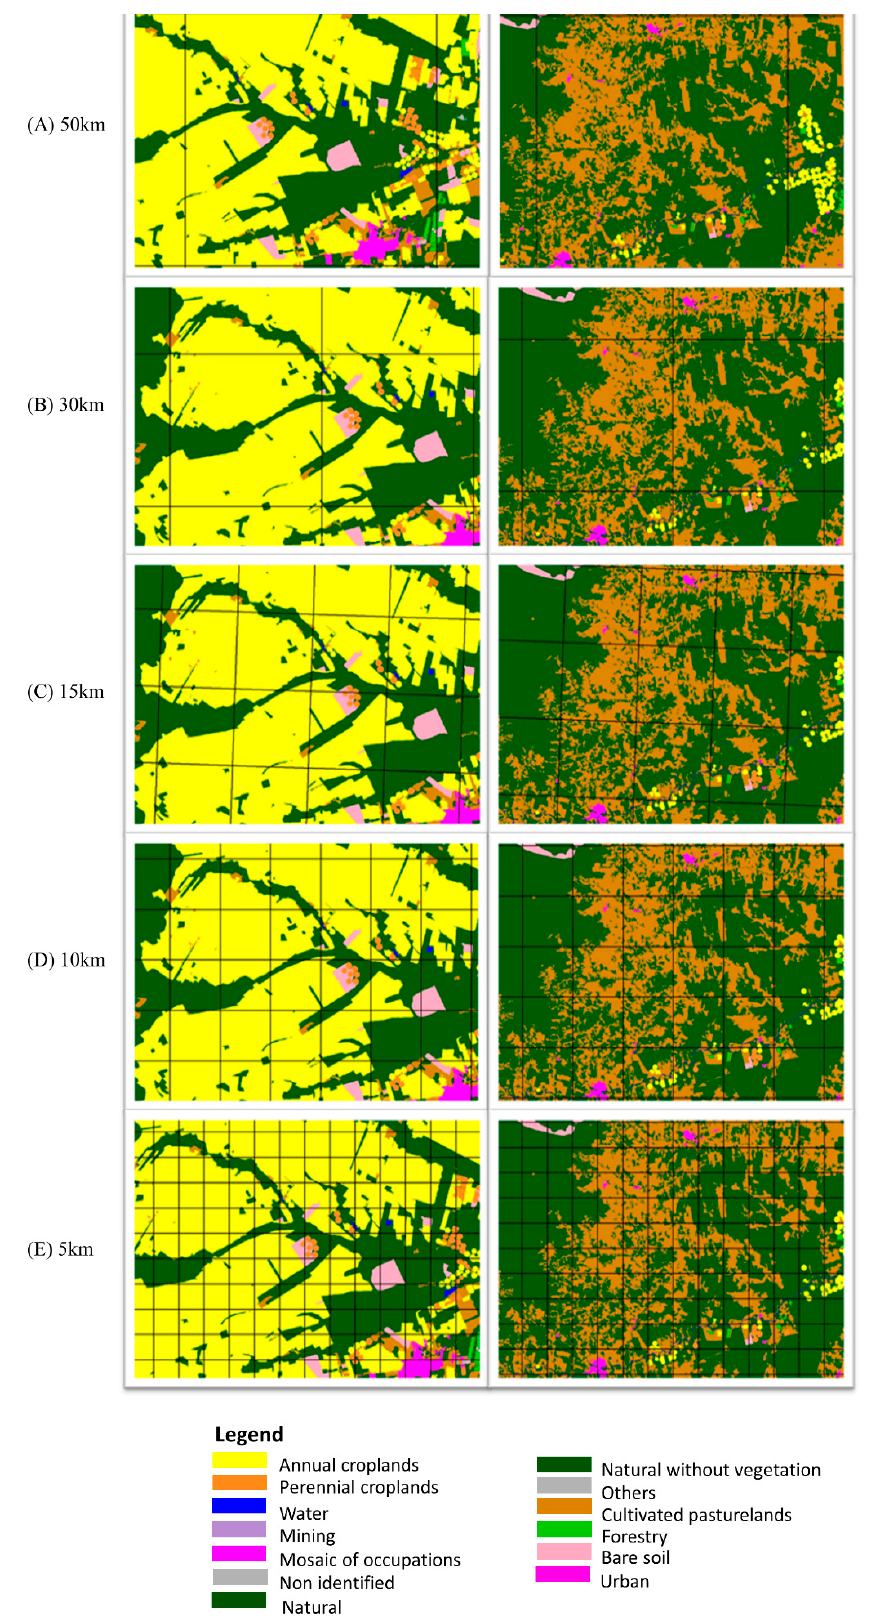
Figure 2. TerraClass 2013 land use and land cover (LULC) map in the study area and different cell size: ( A ) 50 km; ( B ) 30 km; ( C ) 15 km; ( D ) 10 km; ( E ) 5 km. On the left, a region with a predominance of large LULC areas, and the right, a region with a predominance of small LULC areas.